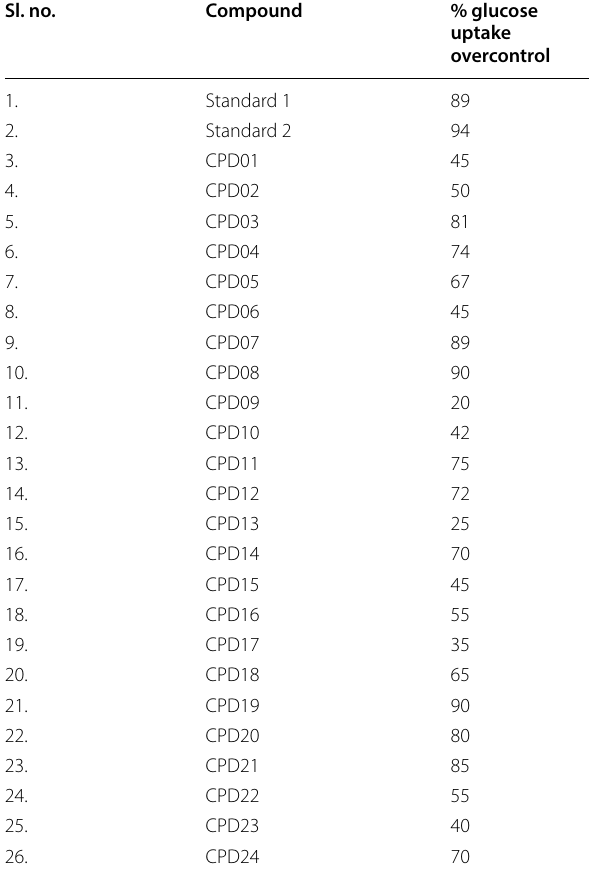
Table 5 Glucose uptake activity of the synthesized compounds Sl.